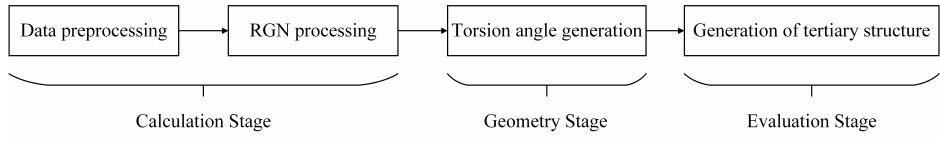
Figure 1. RGN prediction process.